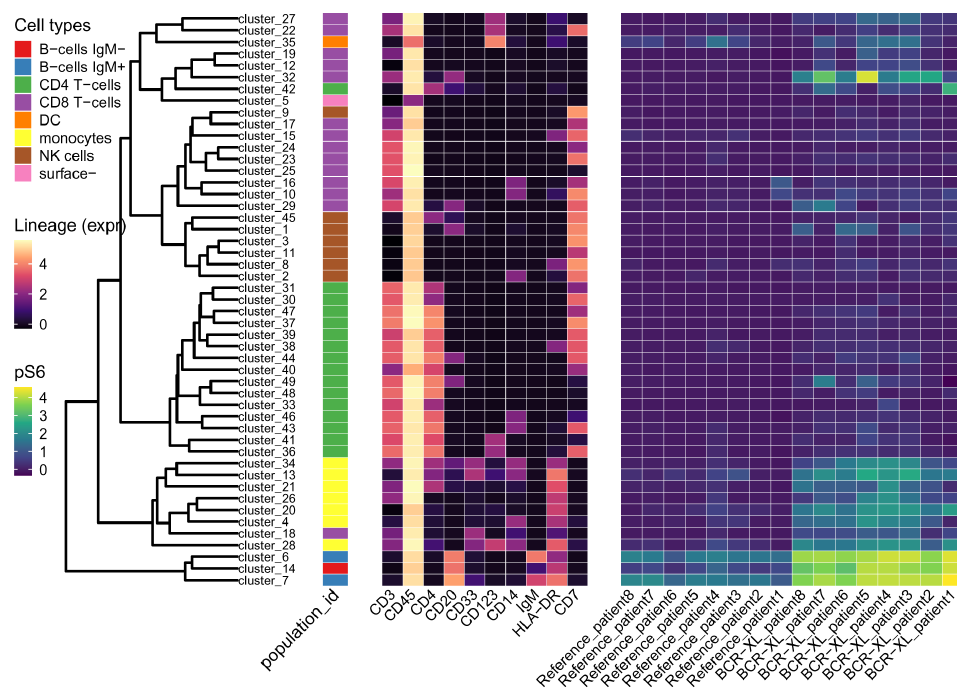
Figure 12. The median expression of markers across 49 cell clusters. Leaves of the tree are labeled with their corresponding cell clusters. Cell types (population_id) of leaves are shown in the first heatmap. Median expressions of ten lineage markers on each leaf are shown in the middle heatmap. Cell clusters in the same branch show similar expression patterns of lineage markers. The right heatmap is about the median expression of a functional marker pS6 in clusters (rows) per sample